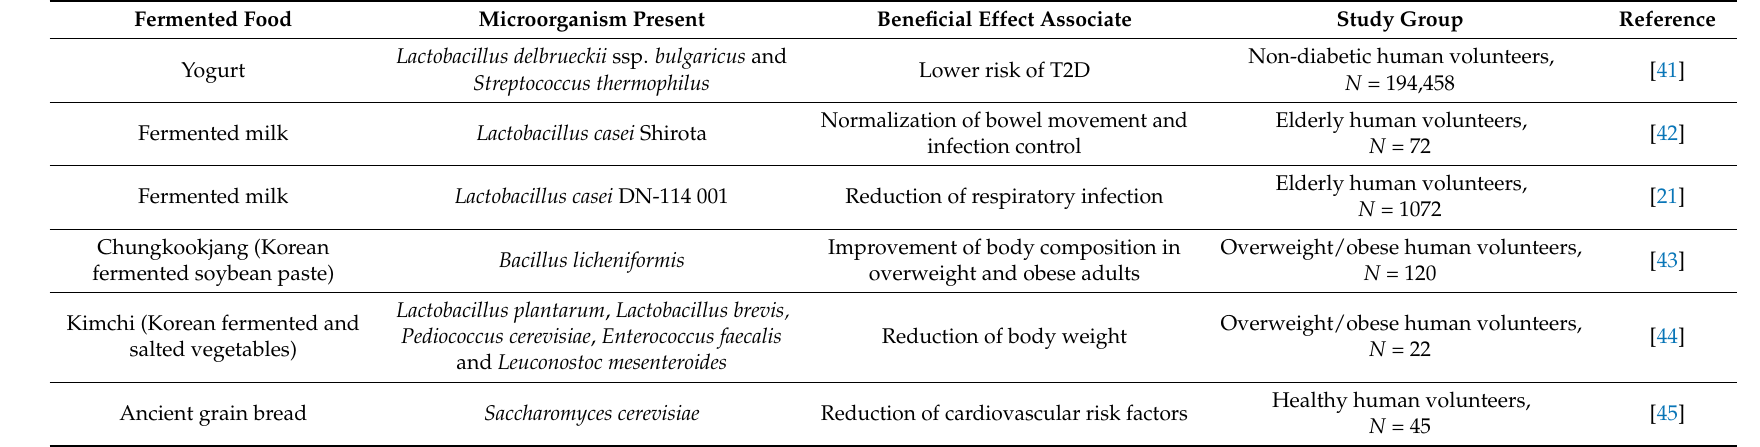
Table 1. Examples of the impact studies of fermented foods on